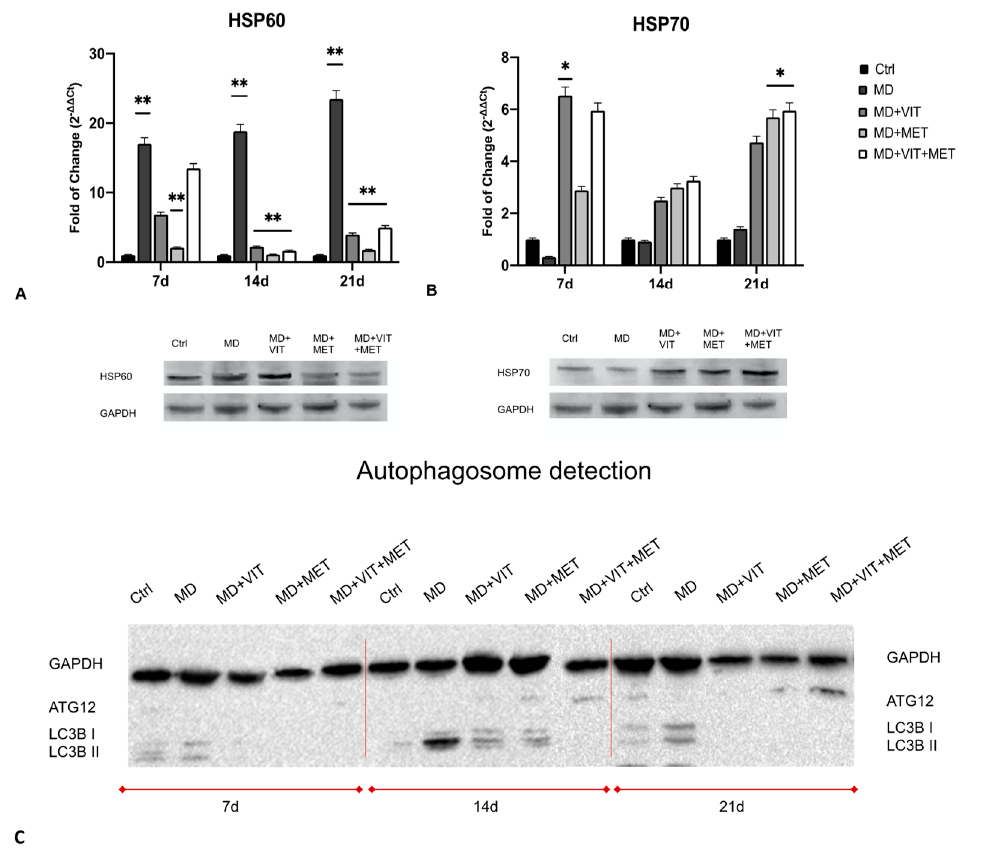
Figure 4. Analysis of heat shock proteins: The expression of HSP60 ( A ) and HSP70 ( B ) was evaluated after 7, 14, and 21 days in ADSCs cultured in the presence of adipogenic differentiation medium (MD) (blue bars), or in MD plus vitamin D (MD+VIT) (yellow bars), or in MD plus metformin (MD+MET) (orange bars), or in MD with both metformin and vitamin D (MD+VIT+MET) (red bars), as compared to control untreated cells (grey bars). The mRNA levels for each gene were normalized to Glyceraldehyde-3-Phosphate-Dehydrogenase (GAPDH) and expressed as fold of change (2 −∆∆ Ct ) of the mRNA levels observed in undifferentiated control ADSCs defined as 1 (mean ± SD; n = 6). Data are expressed as mean ± SD referred to the control (* p ≤ 0.05; ** p ≤ 0.01). ( C ) Analysis of autophagosome formation. The protein levels were analyzed on ADSCs cultured in the presence of adipogenic differentiation medium (MD), or in MD plus vitamin D (MD+VIT), or in MD plus metformin (MD+MET), or in MD with both metformin and vitamin D (MD+VIT+MET), as compared to control untreated cells (Ctrl) after 7, 14, and 21 days by Western blot, using Autophagosome Marker Antibody Sampler Kit. The sizes of the bands were determined using pre-stained marker proteins. The data presented are representative of different independent experiments.